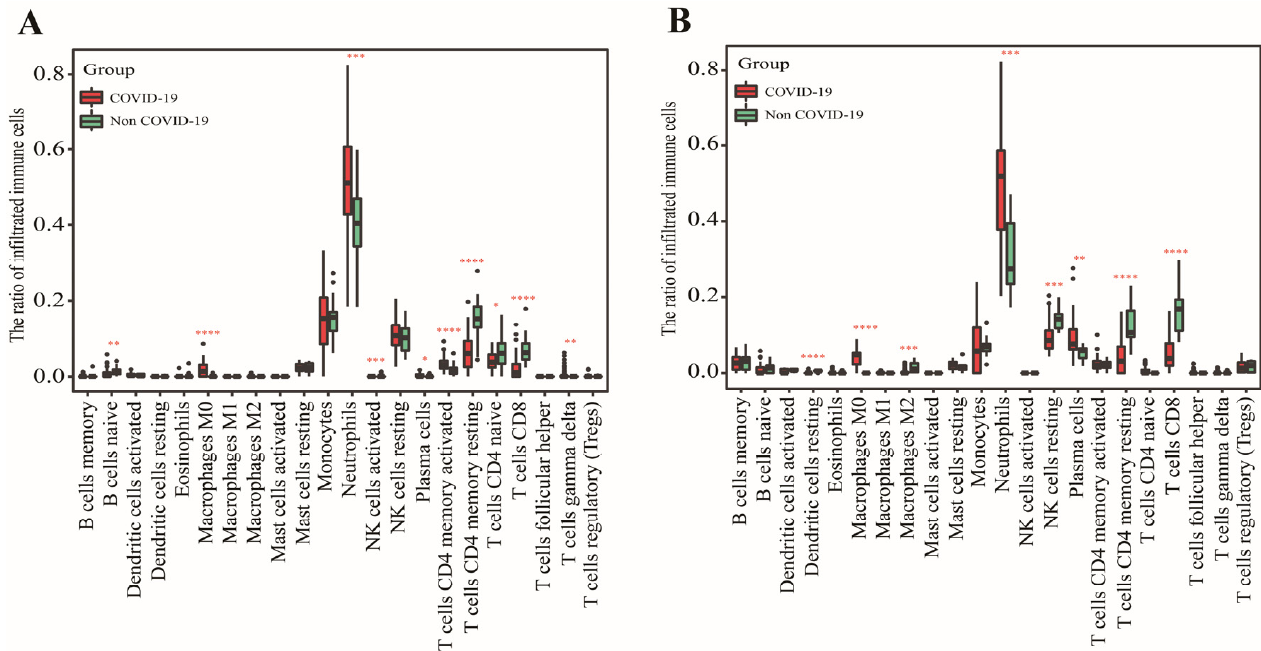
Figure 2. The determination of differentially distributed immune cells. ( A ) The fraction of 22 immune cells between COVID-19 patients and healthy controls in GSE152641. ( B ) The fraction of 22 immune cells between COVID-19 patients and healthy controls in GSE171110. Data were analyzed by Wilcoxon test; ns, no significance;* p < 0.05, ** p < 0.01, *** p < 0.001 and **** p < 0.0001.